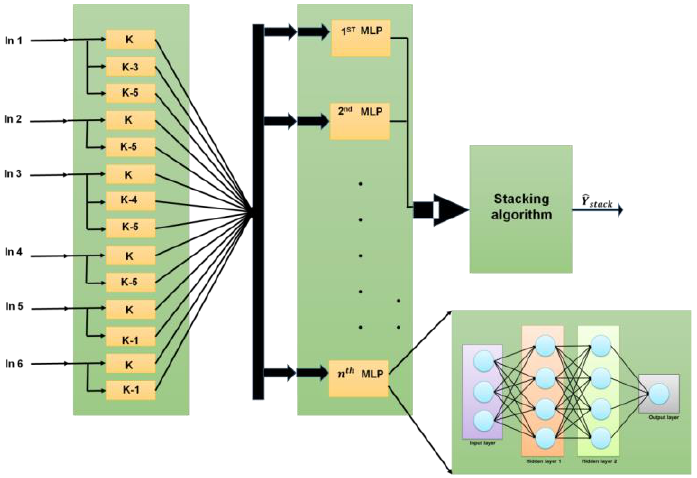
Figure 2. Elaborative stepwise stacked artificial neural networks. Level of input: It receives inputs given by the user in a variety of ways. Level of hidden: Hidden levels are shown between the input and output levels. It performs all the computations necessary to uncover the connections and hidden characteristics. Level of output: This layer is used to communicate the output after the data have undergone several alterations in the hidden layer.